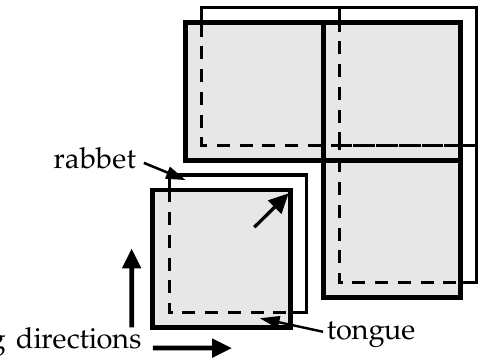
tongue possible printing directions Figure 7. Arrangement of segments and geometric positioning of rabbet and Figure 7. Arrangement of segments and geometric positioning of rabbet and tongue.